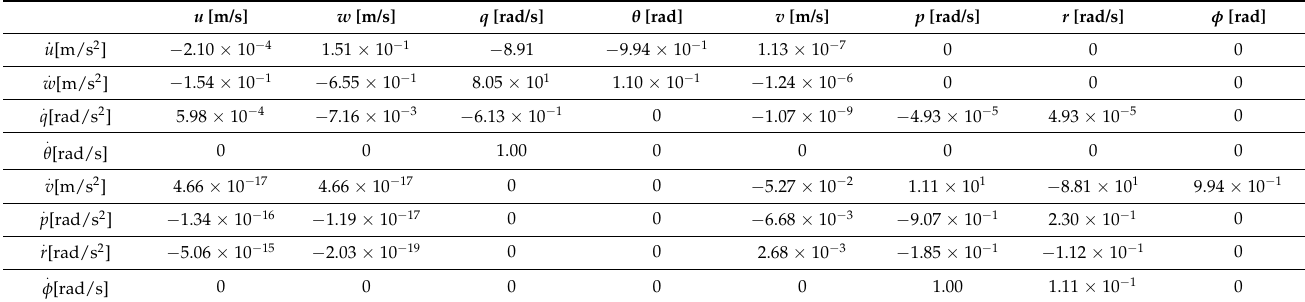
Table 4. Re-arranged 8x8 stability matrix for case 1a in Table 3.